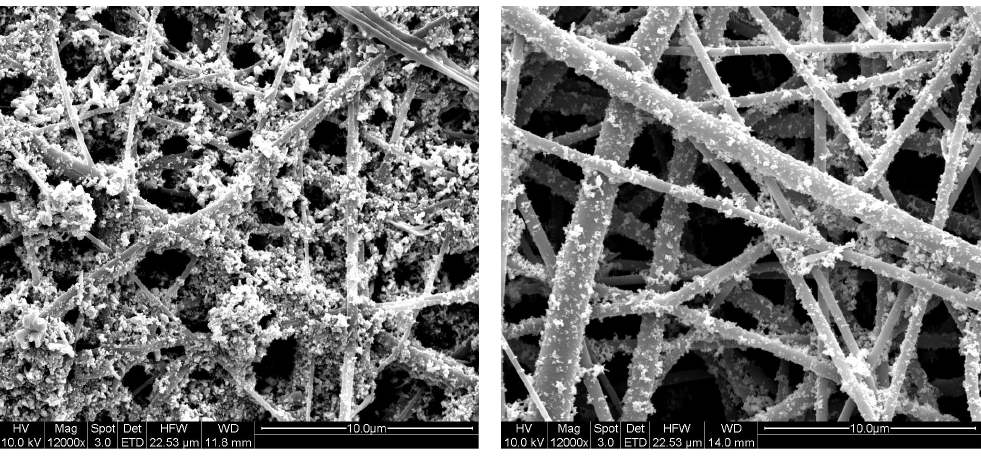
Figure 3. SEM images of dip coated samples of CA/PET-ZnO (left) and PET-ZnO (right) (Adapted from